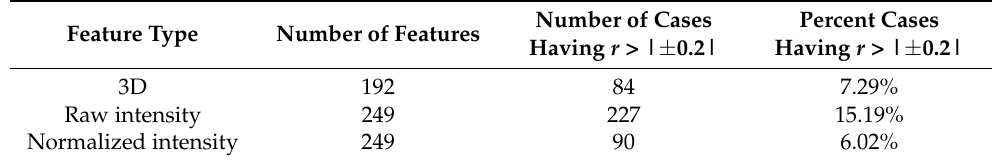
Table 4. Number and percentage of cases having a correlation ( r ) greater than | ± 0.2| between mean scan angle and feature